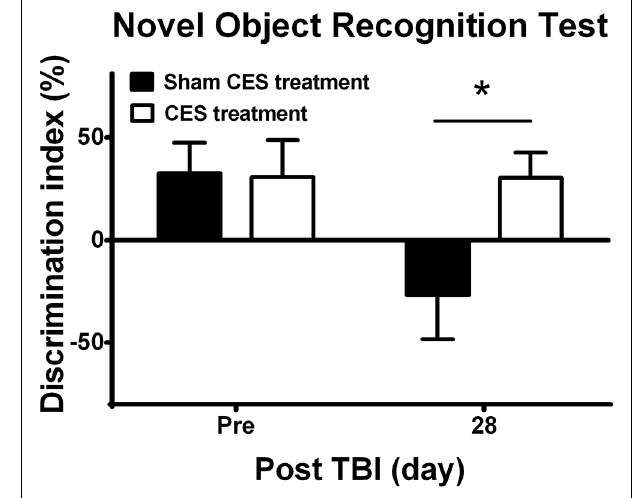
FIGURE 5 | Effect of CES treatment on sensory function assessed by adhesive removal test. Values are expressed as the mean ± SEM. * p < 0.05, significant difference between the two groups.